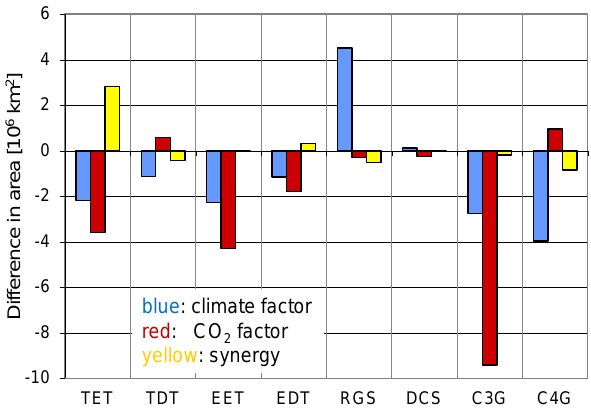
Fig. 6. Differences in global areal coverage (in 10 6 km 2 ) for dif- ferent PFTs (for acronyms see Fig. 4). Blue columns refer to the pure contribution of differences in climate, including differences in ice sheet and land-sea distribution, to differences between glacial and pre-industrial potential coverage by each PFT (Eq. 1a). Brown columns refer to the pure contribution due to the ecophysiological effect of different CO 2 concentration in glacial and pre-industrial climate (Eq. 1b). Yellow columns depict the synergy between the pure contributions (Eq. 1c).